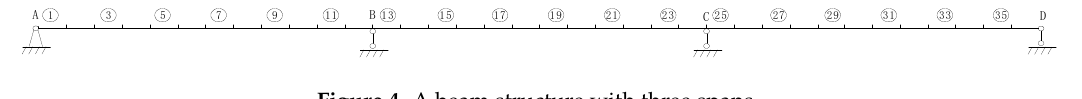
Figure 4. A beam structure with three spans.